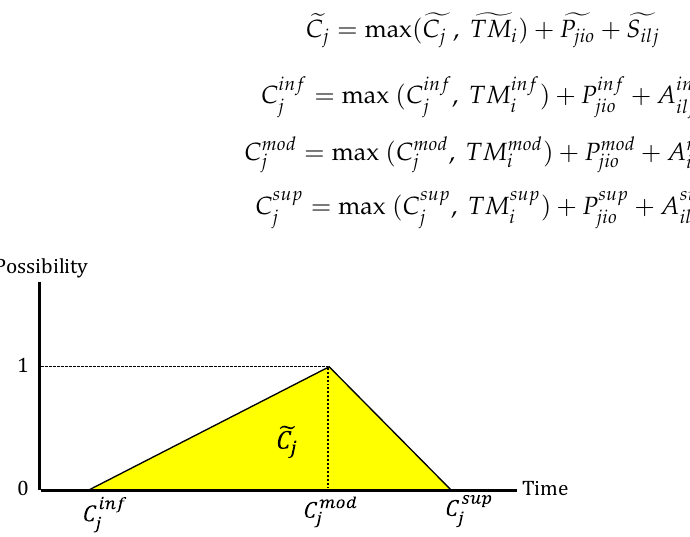
Figure 5. Triangular membership function for the completion time of job j.